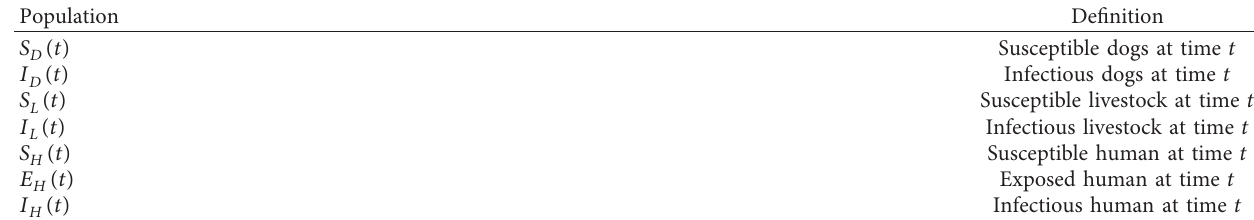
Table 1: Variables in the model (adapted from [12]).